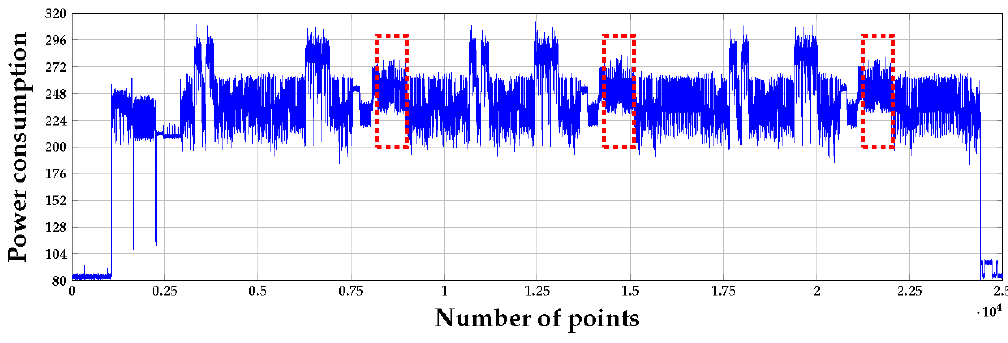
Figure 4. Measured trace when performing the financial IC card protocol.